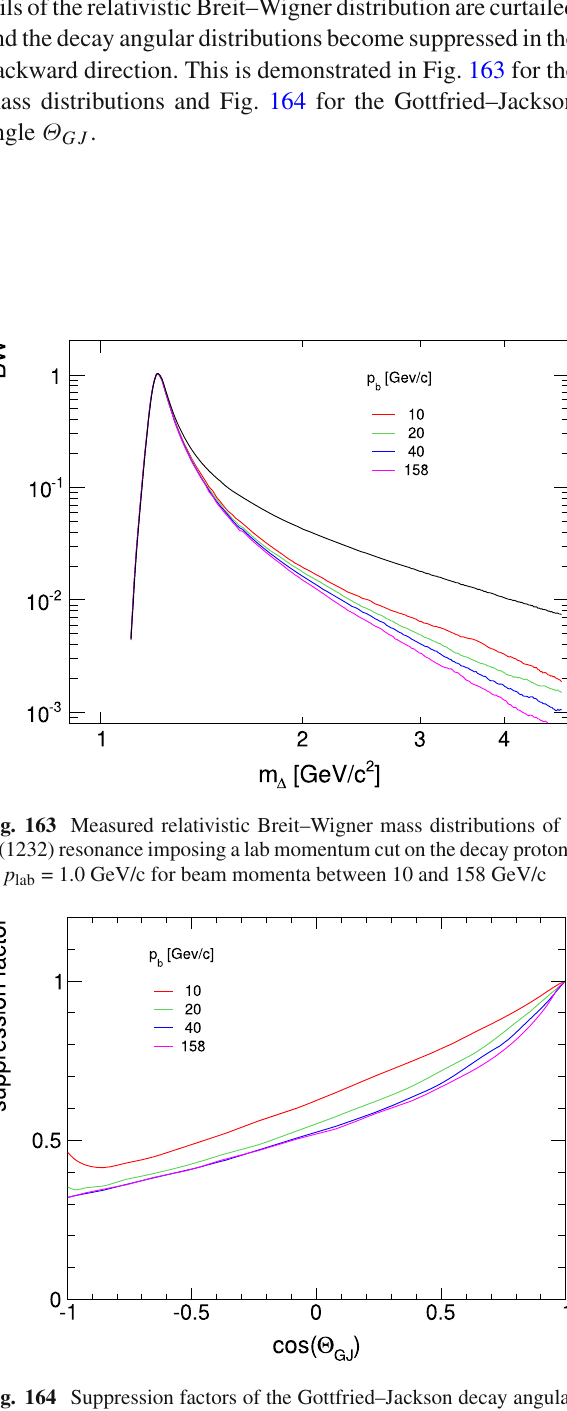
Fig. 164 Suppression factors of the Gottfried–Jackson decay angular distribution in backward direction as a consequence of a proton p lab cut at 1.0 GeV/c as a function of cos( Θ GJ ) and beam momenta between 10 and 158